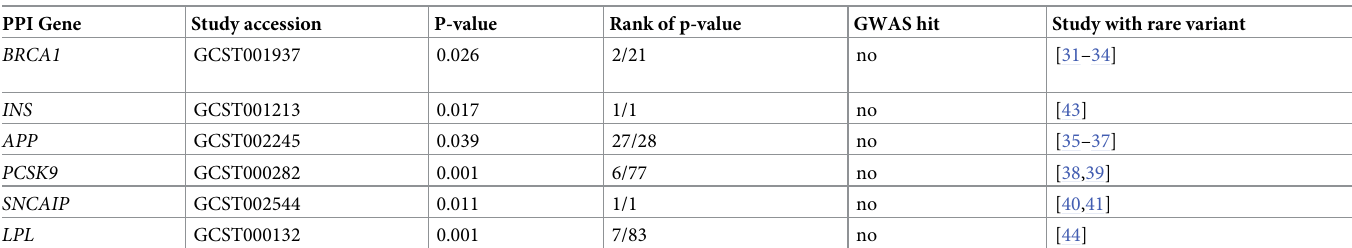
Table 1. Examples of PPI